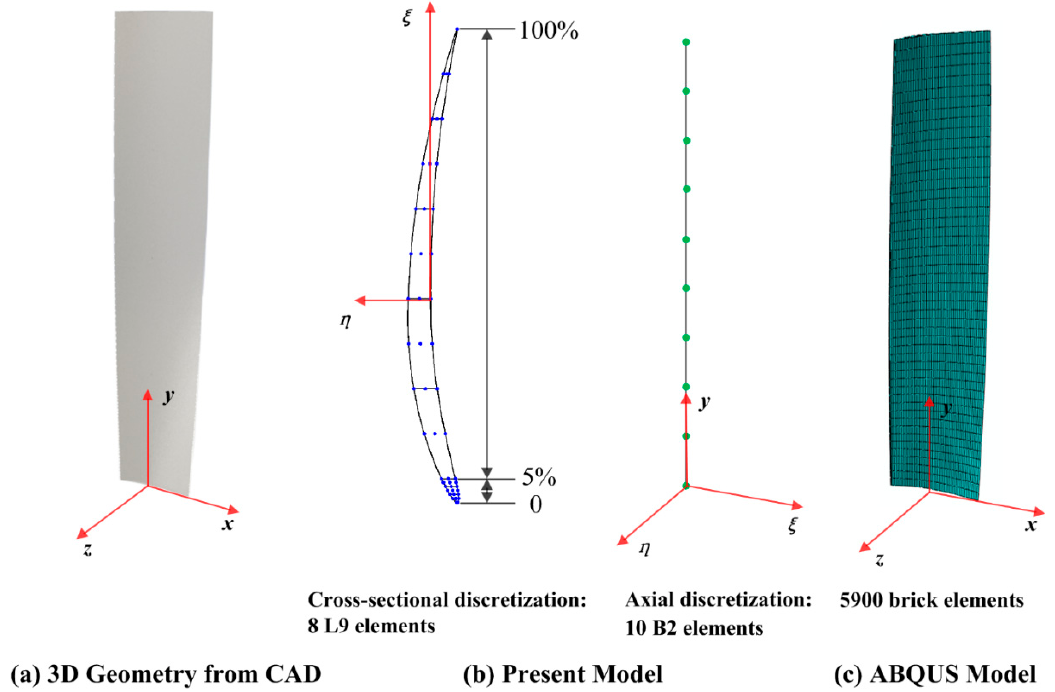
Figure 14. Geometries of a pre-twisted cantilever with airfoil profile cross section and remarkable difference in discretization between the present model and ABAQUS model: ( a ) 3D geometries from CAD in ( e x , e y , e z ), ( b ) 8 L9 elements for cross-sectional discretization and 10 2-node beam (B2) elements for axial discretization based on current formulations in ( e ξ , e y , e η ), and ( c ) converged 5900 brick elements from ABAQUS in ( e x , e y , e z ).